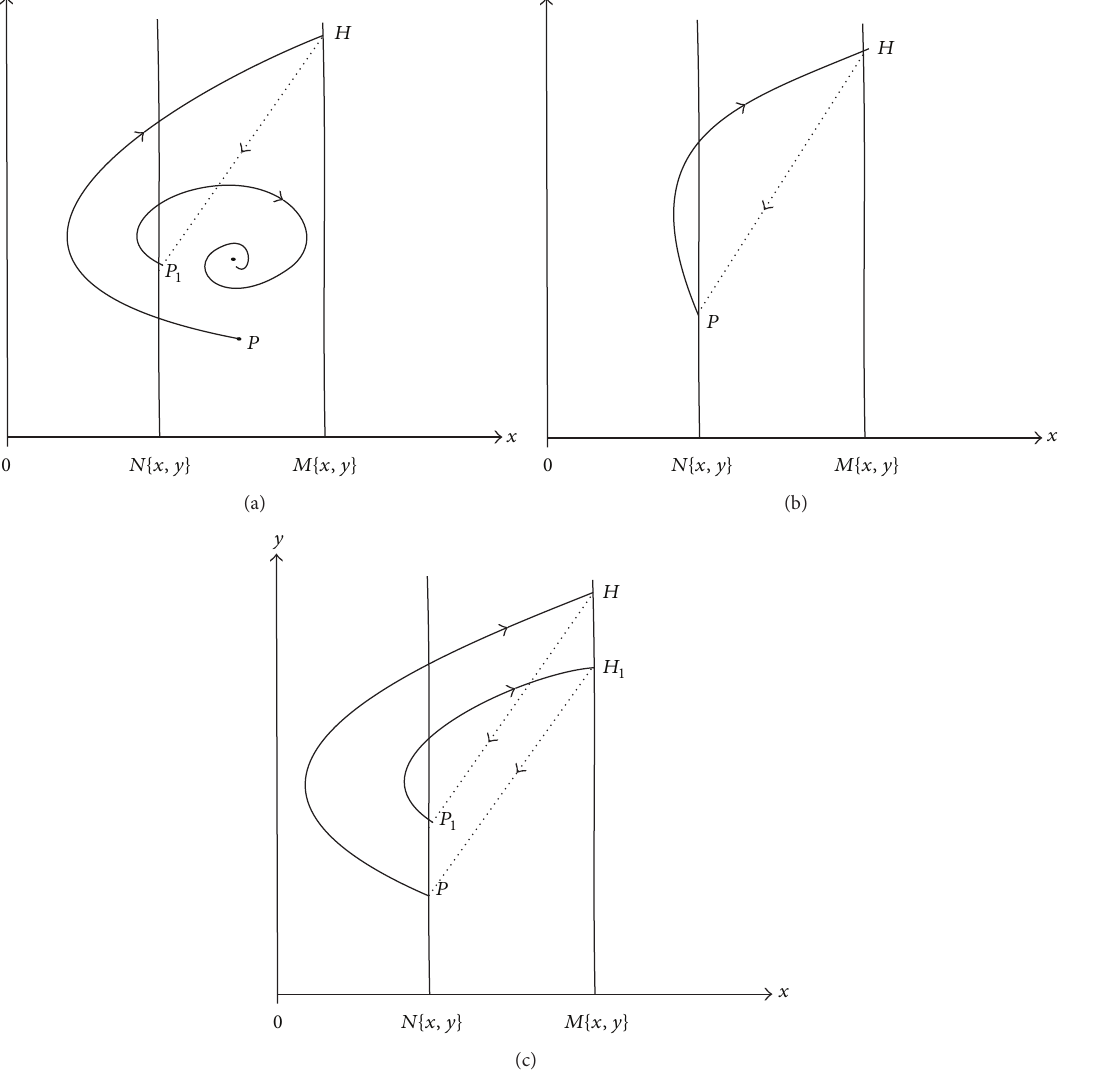
Figure 1: (a) The solution mapping of the system (4). (b) The order one periodic solution of the system (4). (c) The order two periodic solution of the system